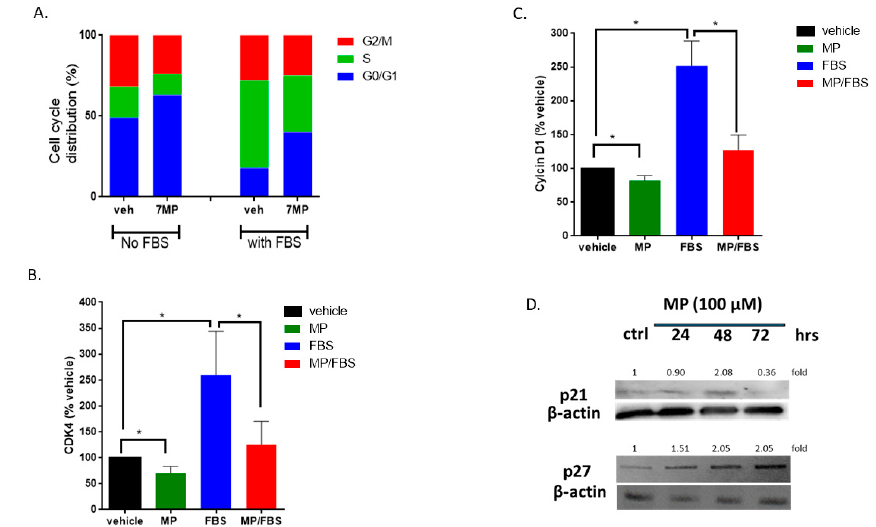
Figure 3. MP blocks VSMCs in G 0 / G 1 phase of cell cycle. ( A ) Cells were treated with MP (100 µ M) for 48 h, stained with PI, then sorted by flow cytometer. Data represent the mean of three independent experiments. ( B ) and ( C ) Cells were grown in starvation or complete medium, in presence or absence of MP (100 µM). The expression levels of CDK4 ( B ) and Cyclin D1 ( C ) were determined by RT-PCR. Values are calculated as % of the corresponding vehicle control value and represented as mean ± SEM of three replicates. (* p < 0.05). ( D ) Cells were treated with MP (100 µM) for 24, 48, and 72 h. The expression of p21 and p27 was detected by Western blotting. Values mean fold change of three replicates. One-way ANOVA followed by Tukey’s test was performed for all panels.